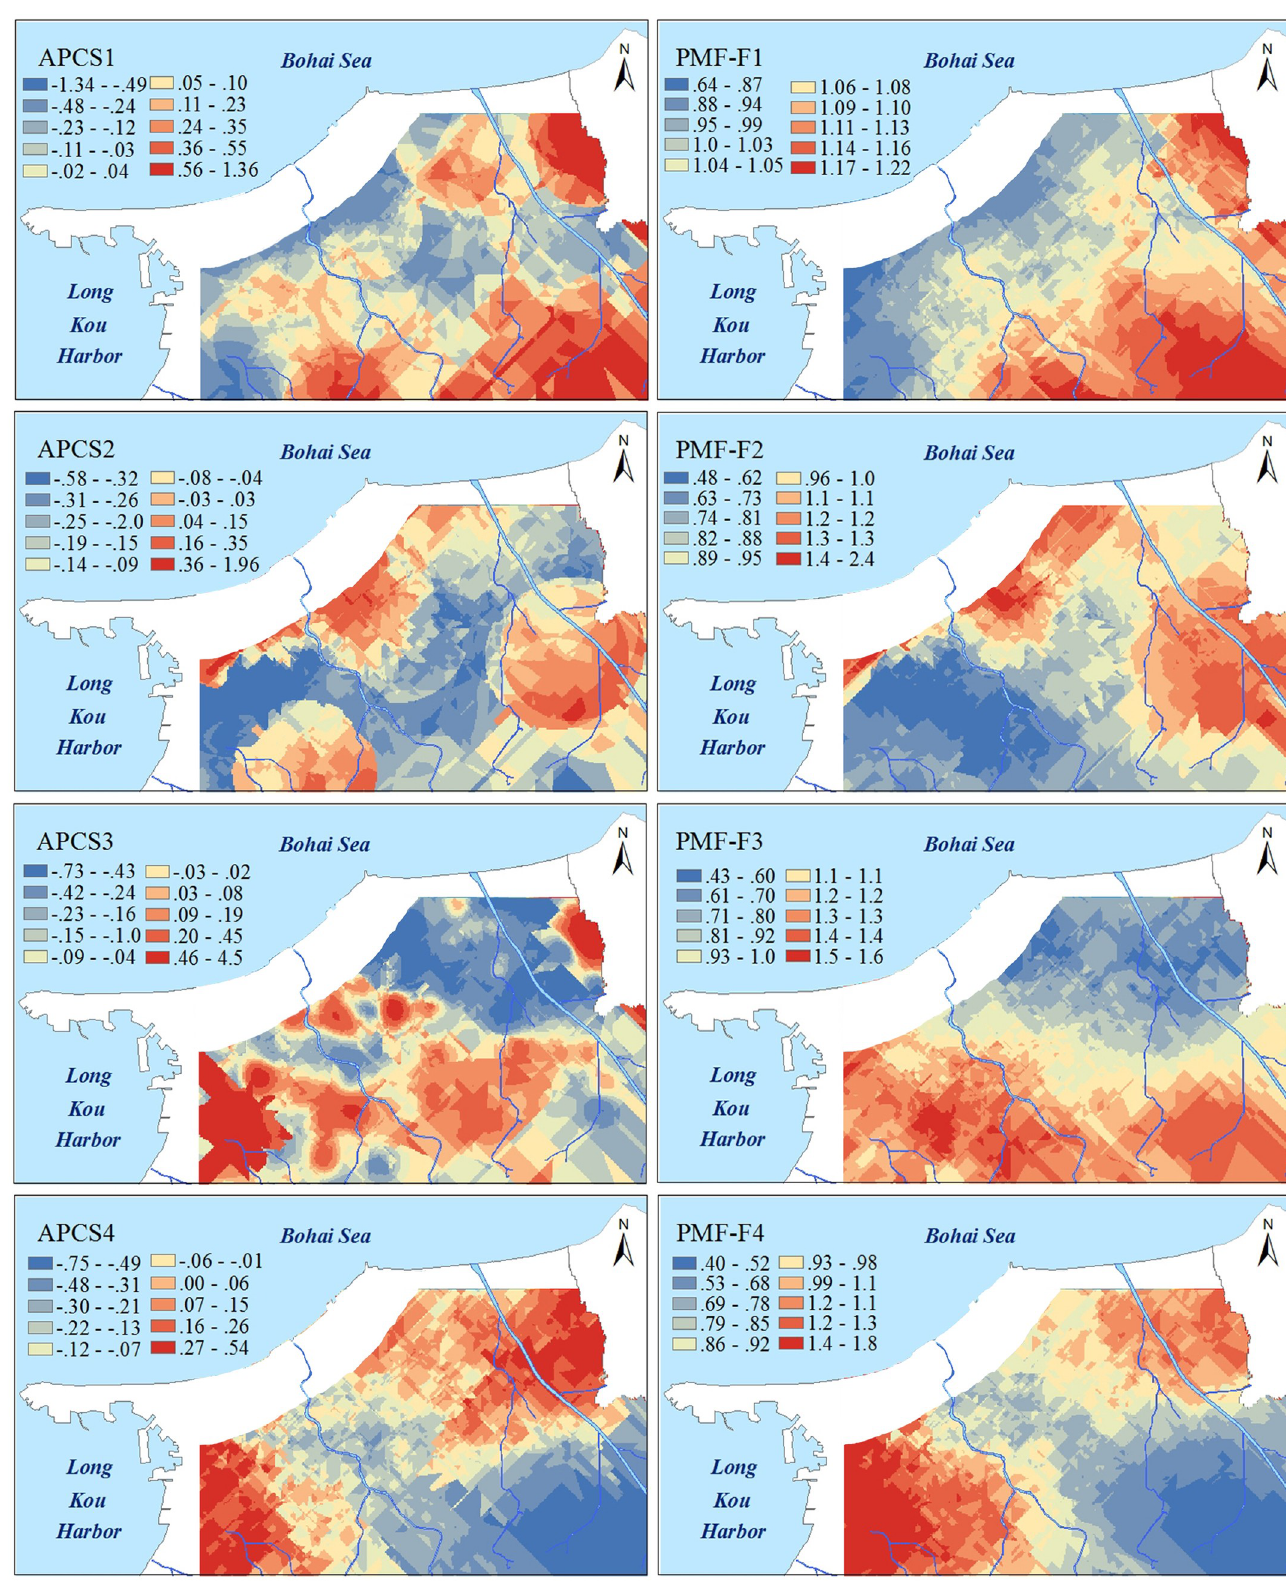
Fig 5. Kriged interpolation of the APCS and PMF factors. (The interpolated map plotted with the optimal ordinary kriged interpolation model). https://doi.org/10.1371/journal.pone.0238513.g005 PLOS ONE | https://doi.org/10.1371/journal.pone.0238513 September 3,